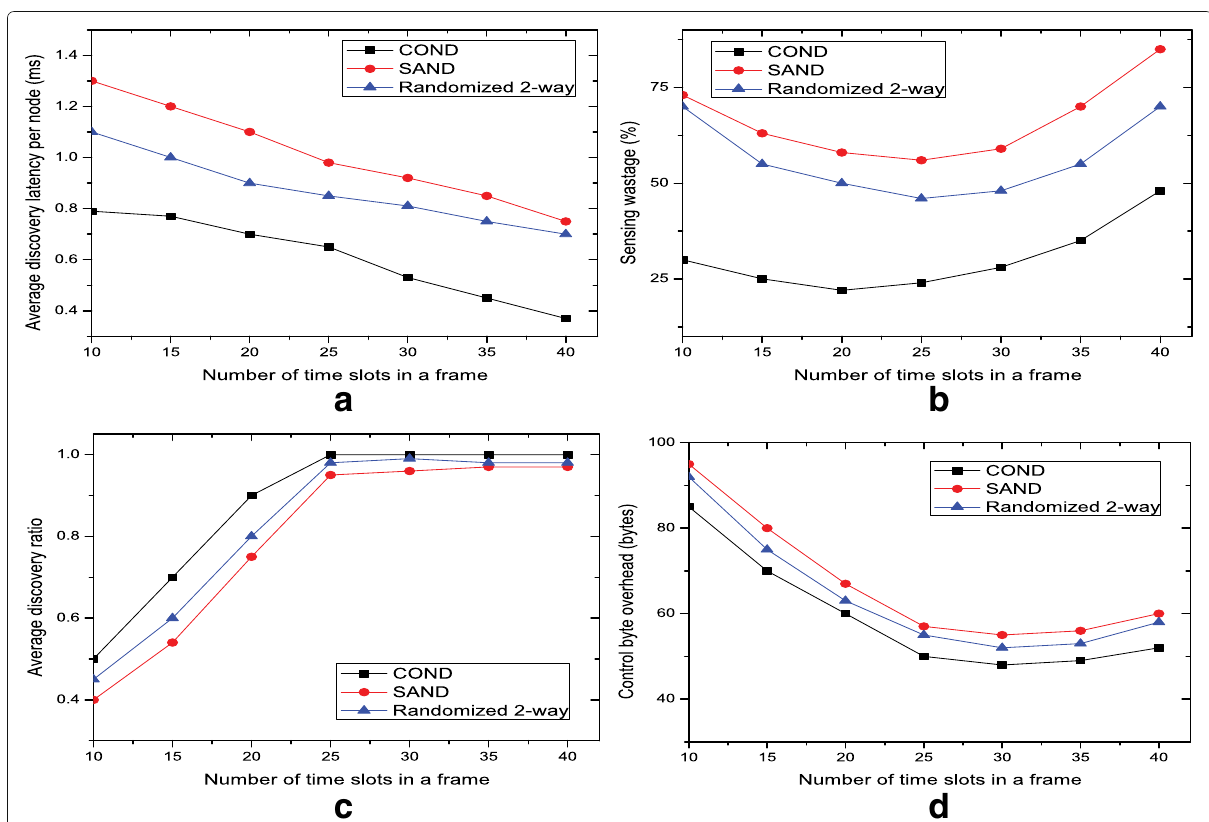
Fig. 8 Impacts of number of time slots in a frame on performances of the studied neighbor discovery algorithms. a Average discovery latency. b Sensing wastage of discovery slots. c Average discovery ration. d Control byte overhead